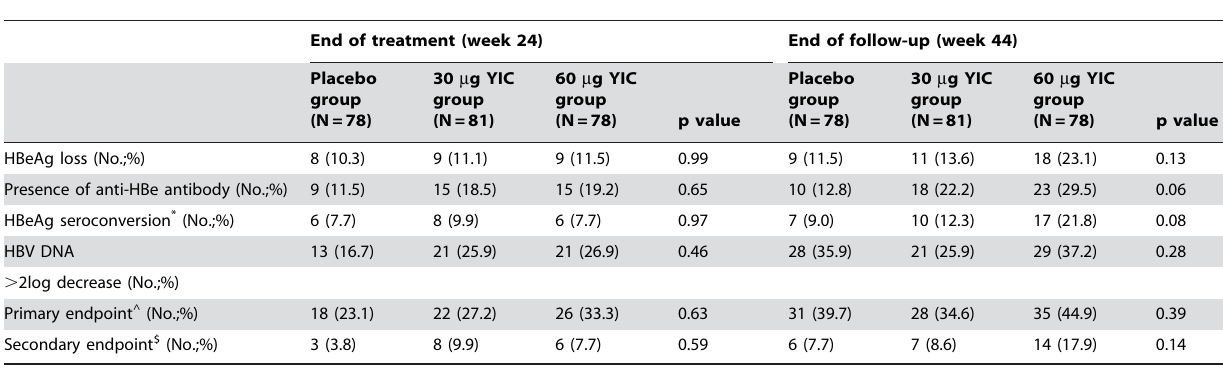
Table 2. Virologic response at the end of treatment and the end of follow-up.